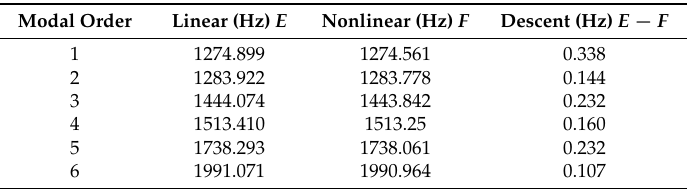
Table 5. The first 6 order linear and nonlinear resonant frequencies of the hard-coating cylindrical shell under a 5 g excitation level.